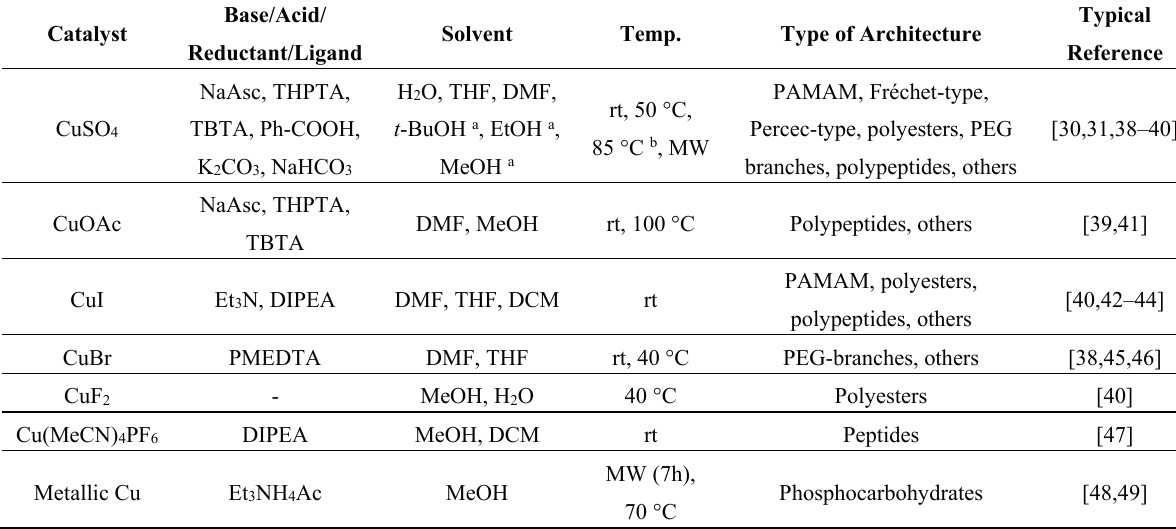
Table 1. CuAAC conditions noted in dendrimer synthesis from 2010 to